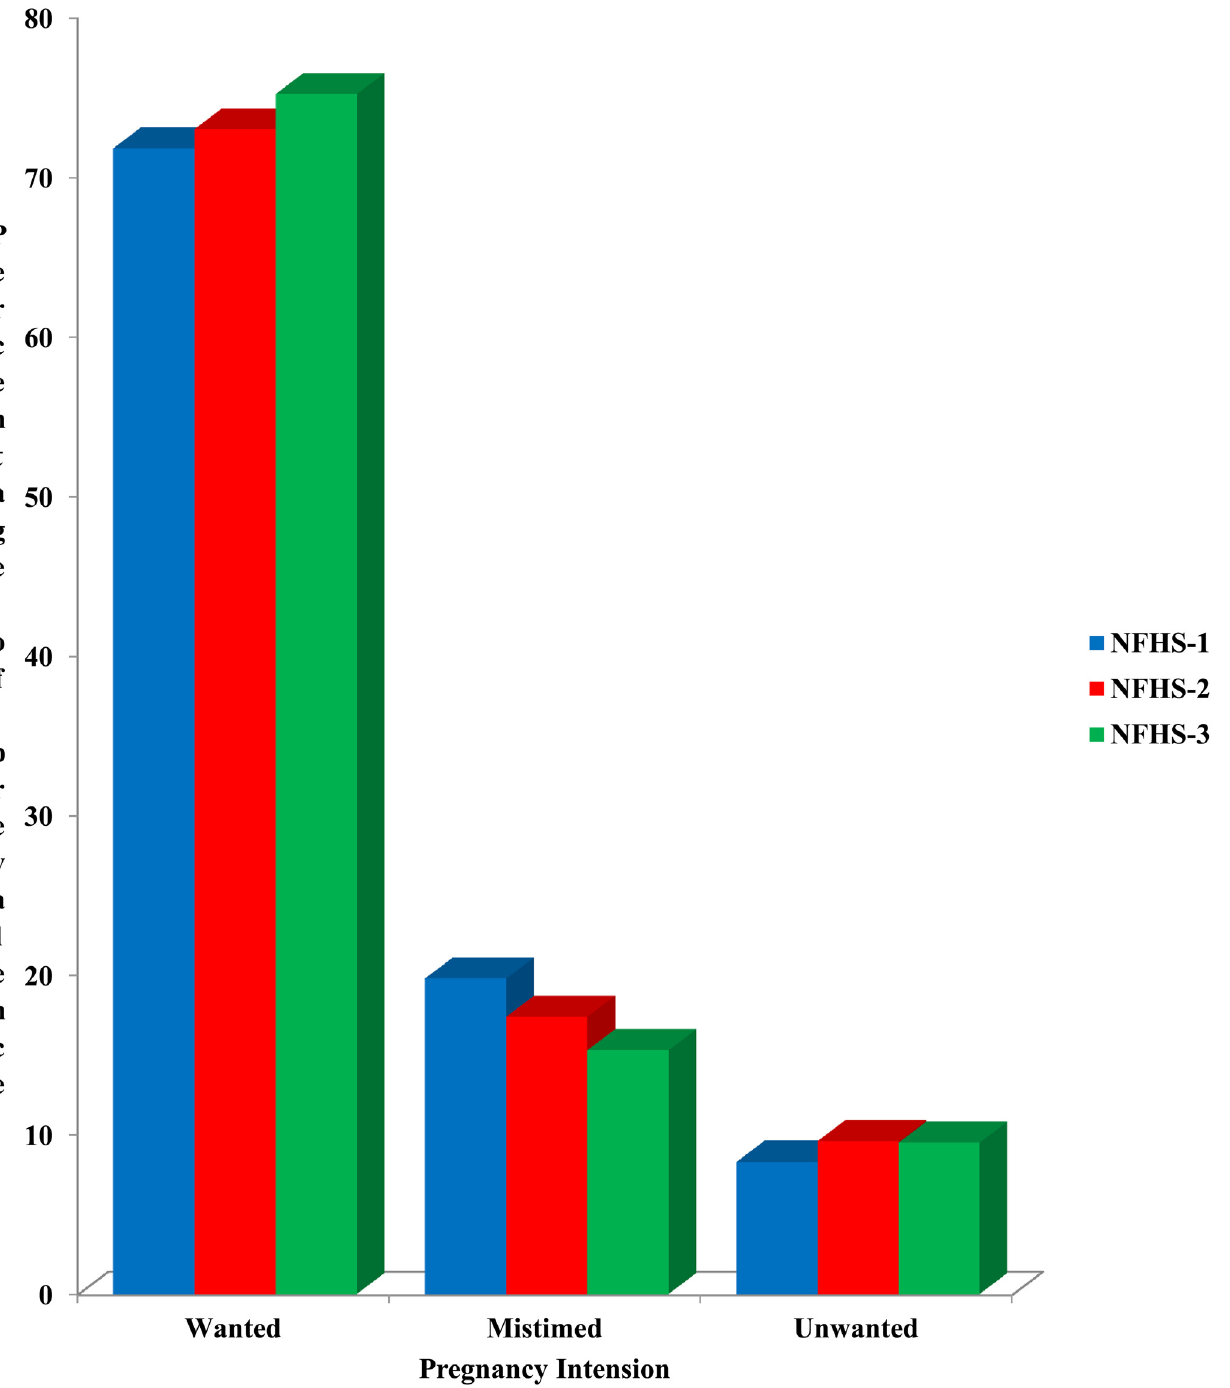
Fig 1. Trend of pregnancy intention among currently pregnant married women.